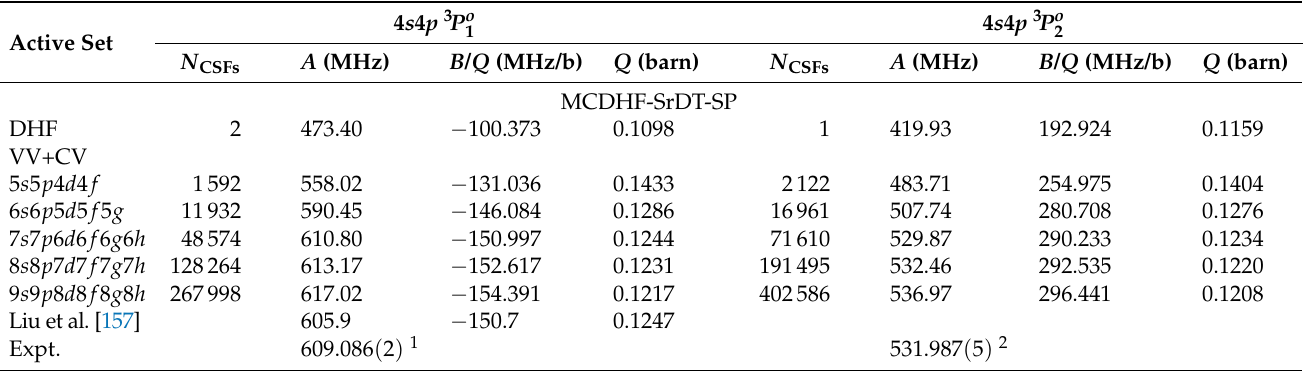
Table 5. A (MHz), B / Q (MHz/b), and Q (in barn) values as functions of the increasing active set of orbitals for the 4 s 4 p 3 P o and 4 s 4 p 3 P o states in 67 Zn I . I π = 5/2 − and µ expt = 0.875479 ( 9 ) µ N . 2 1 The Q -values are extracted from the relation Q = B expt / ( B / Q ) , where the experimental values